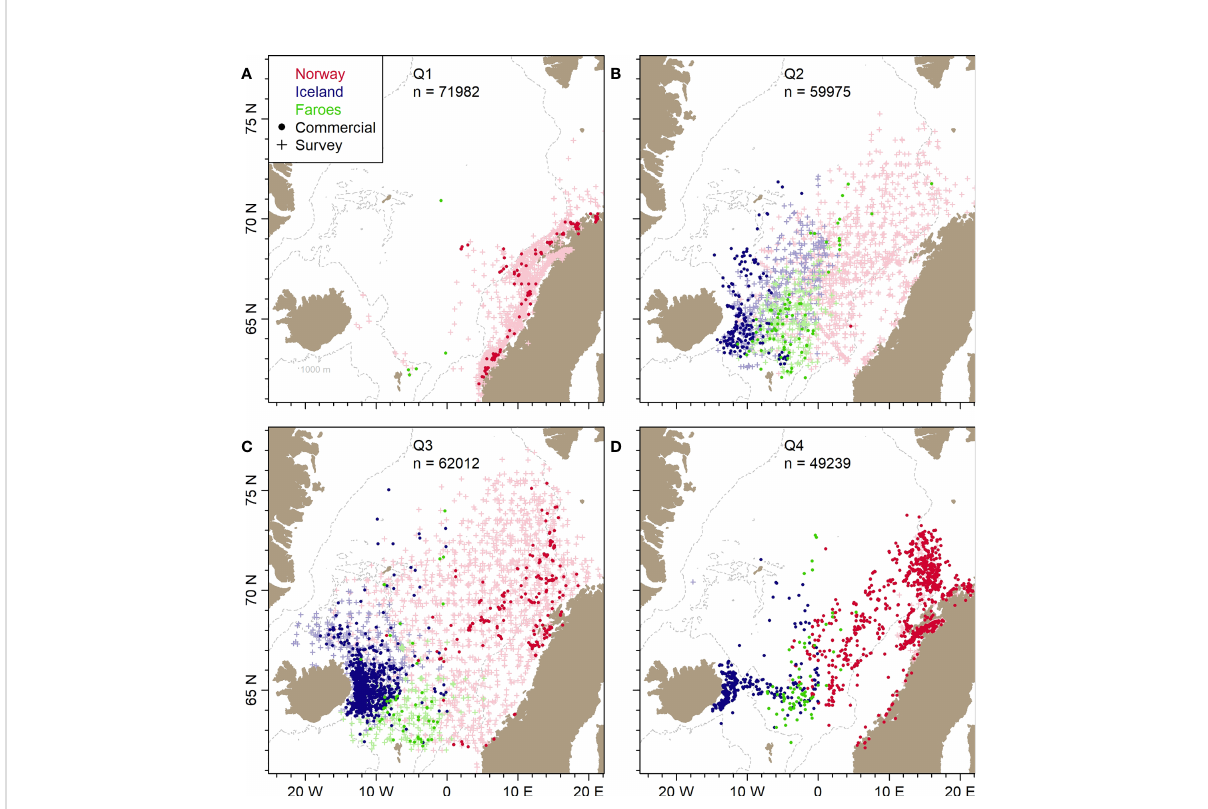
FIGURE 3 Study area. Positions of all Norwegian (red), Icelandic (blue) and Faroese (green) samples of herring from scienti fi c surveys (+) and commercial catches ( (cid:129) ) included in the present study for the period 1994-2019. The panels (A – D) represent annual Quarters